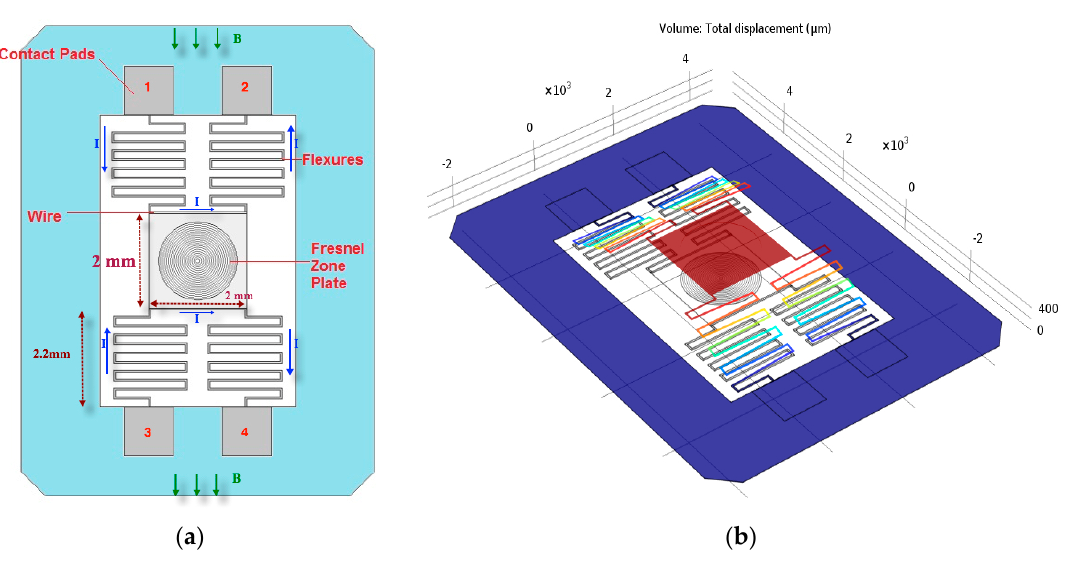
Figure 2. The schematic of the MEMS controlled FZP. The Fresnel zone plate is placed at the centre of the structure. ( a ) Front view of the structure; ( b ) 3D view of FZP in actuated